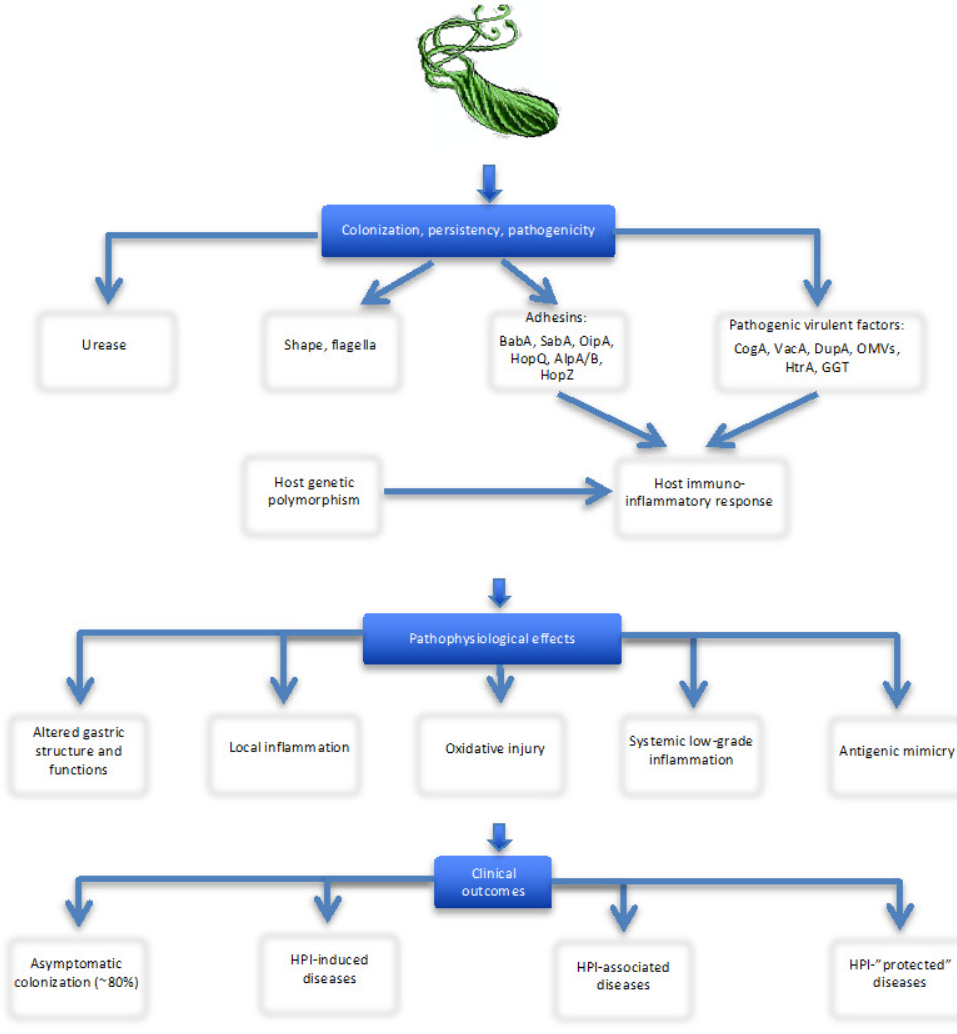
Figure 1. Overview of Helicobacter pylori ( H.p. ) characteristics contributing to gastric colonization, persistence, pathogenicity and clinical outcomes. Abbreviations: AlpA/B, adherence-associated lipoprotein A and B; BabA, blood group antigen-binding adhesin; CagA, cytotoxin associated antigen A; DupA, duodenal ulcer (DU) promoting antigen; GGT, gamma-glutamyl transpeptidase; HopQ, HopZ, H. pylori outer membrane proteins; HtrA, high-temperature requiring protein; OipA, outer inflammatory protein; OMVs, outer membrane vesicles; SabA, sialic acid-binding adhesin; VacA, vacuolating cytotoxin. Notes: The outcome of H.p. is multifactorial and depends on interaction between multiple heterogenic bacterial virulence factors, host genetics, lifestyle and environmental influences. H.p. utilizes a variety of mechanisms which allow: (1) escaping high acid environment (urease, bacterial shape and flagella); (2) attaching to the gastric epithelial layer (adhesin proteins); (3) exerting epithelial cell pathogenicity and (4) a ff ecting the host innate and adaptive immune responses. The expression of virulence factors and host’s immunologic responses (dependent of genetic predisposition /